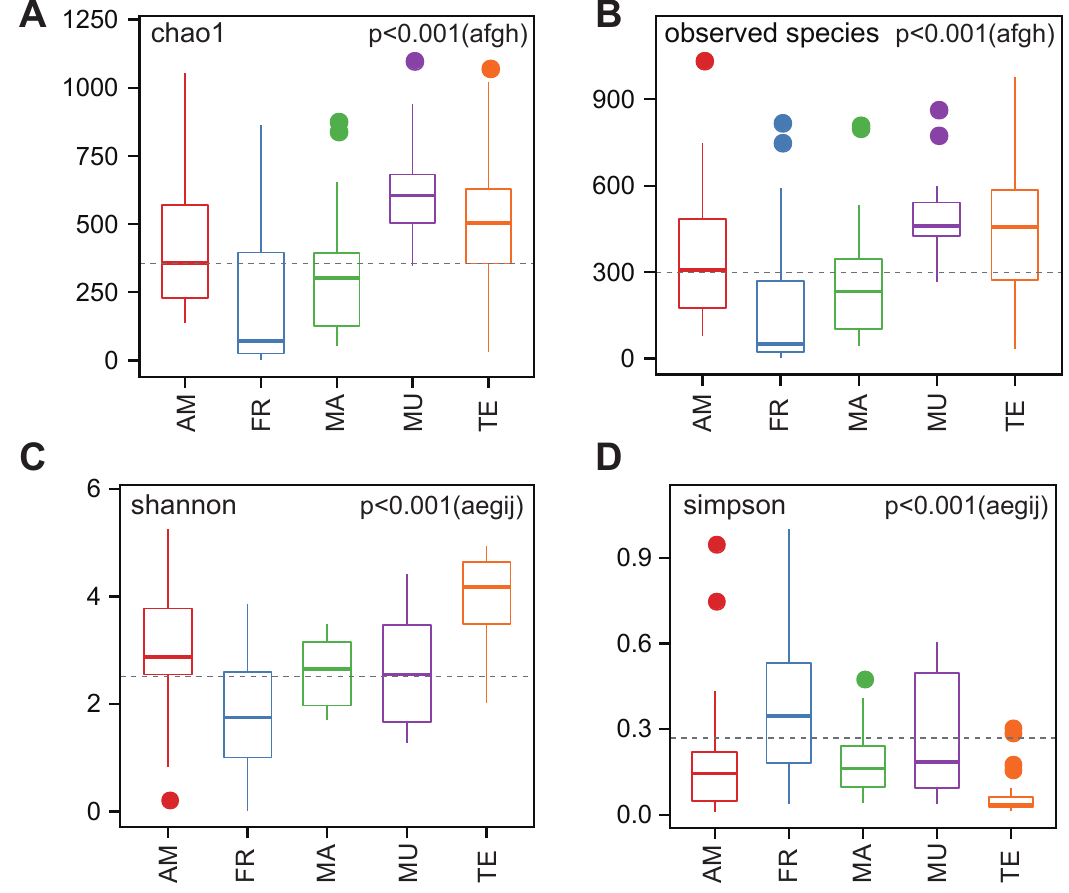
Figure 1. Alpha diversity assessed by richness ( A , B ) and diversity ( C , D ). Boxes represent the interquartile ranges, lines indicate medians, and whiskers indicate the ranges. The five vertebrate groups ( n = 136), including amphibious mudskippers (MU; n = 14), amphibians (AM; n = 25), freshwater fishes (FR; n = 54), marine fishes (MA; n = 23), and terrestrial animals (TE; n = 20), were divided according to their living habitats. a: AM / FR; b: AM / MA; c: AM / MU; d: AM / TE; e: FR / MA; f: FR / MU; g: FR / TE; h: MA / MU; i: MA / TE; j: MU / TE. Please note for the Simpson analysis ( D ) that low values stand for high species